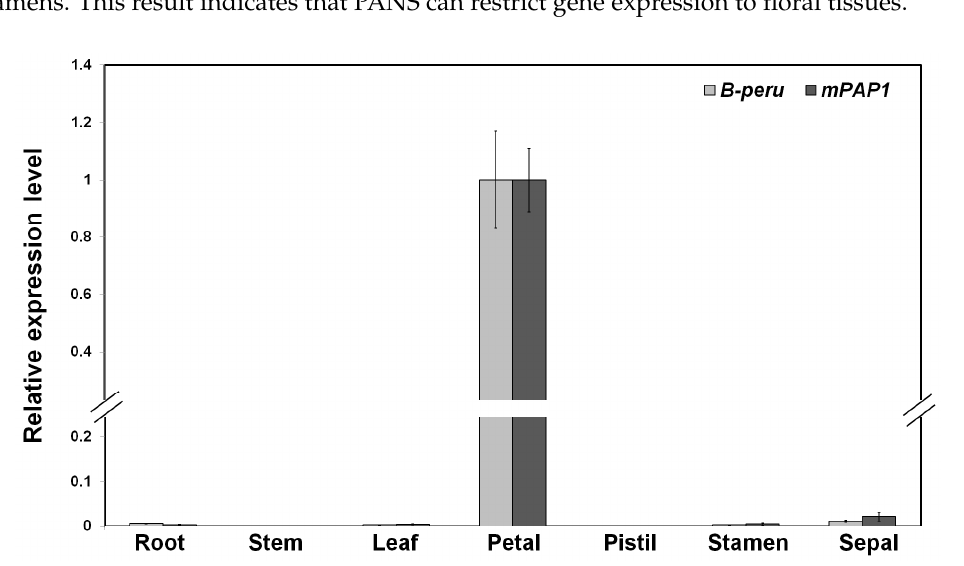
Figure 3. Expression of B-peru and mPAP1 in transgenic tobacco plants transformed with PANSBP. qPCR analysis of the expression levels of B-peru and mPAP1 transgenes in various different tissues of PANSBP-DR line. All results represent mean values ± SD from three biological replicates.